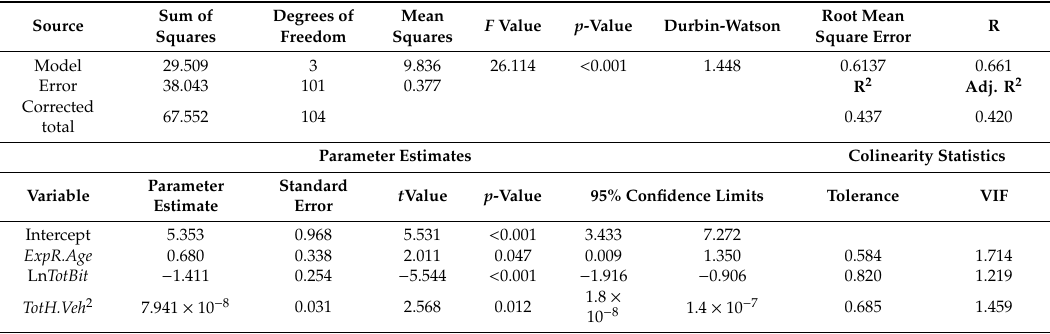
Table 7. Analysis of the Variance of the model of Equation (14).